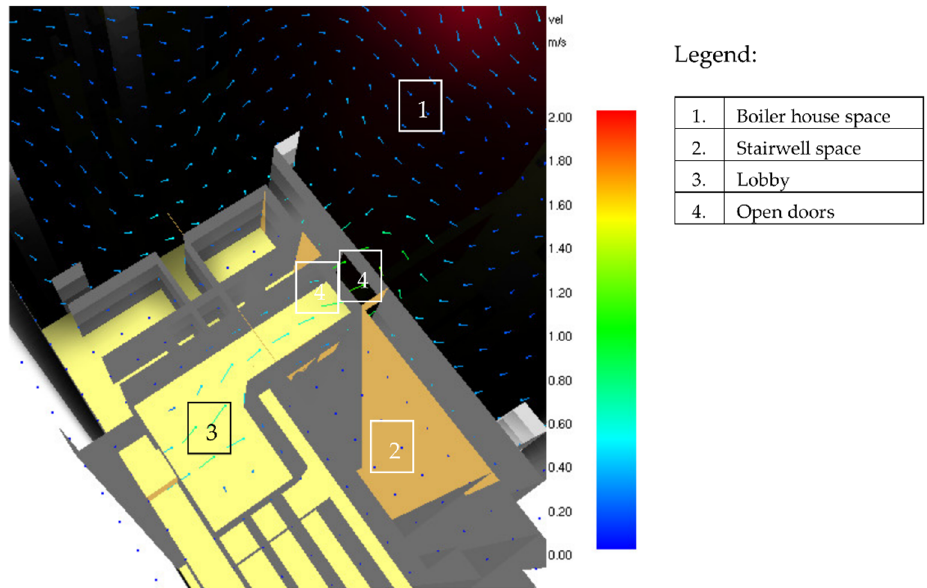
Figure 12. Vestibule and stairwell smoke protection under the boiler room fire conditions, when only the vestibule–boiler room door is open.